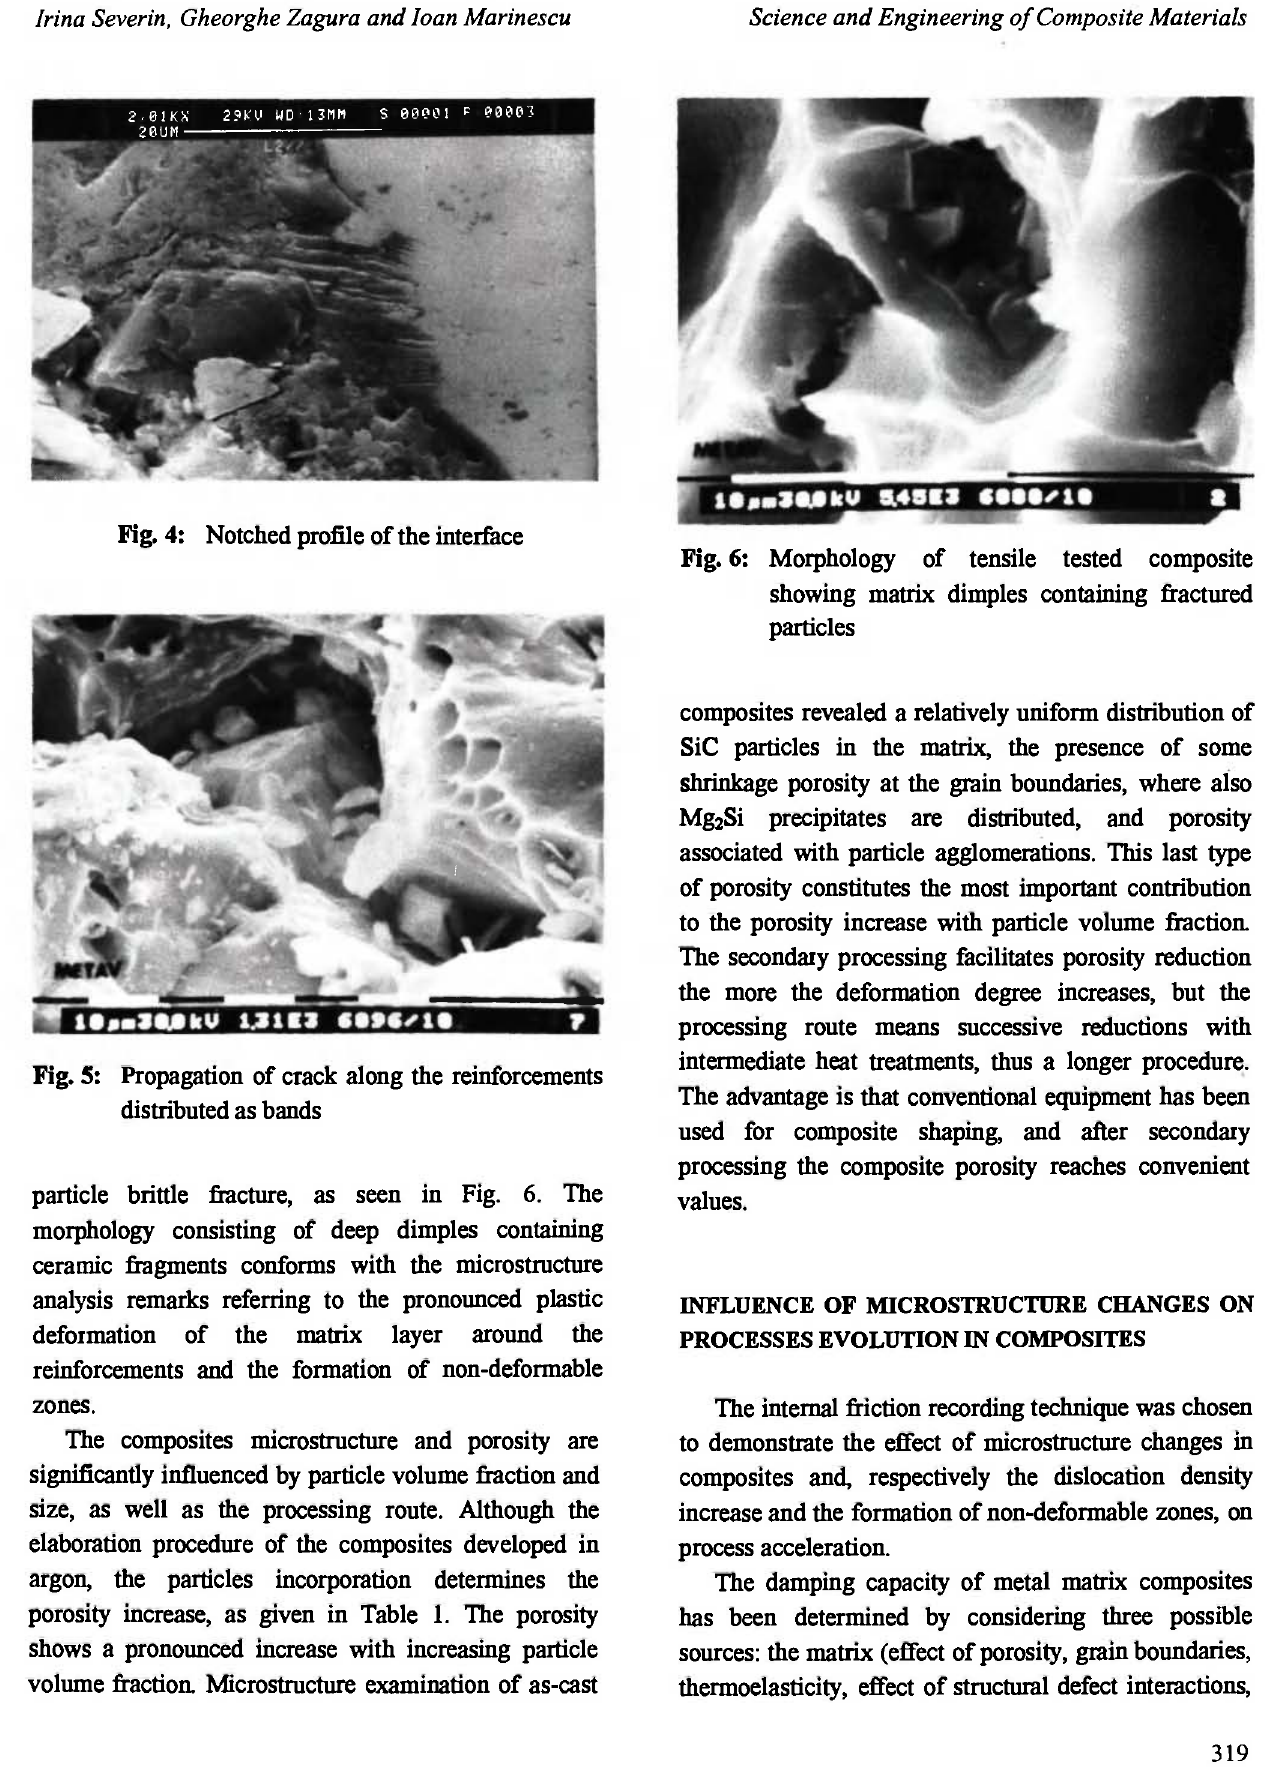
Fig. 4: Notched profile of the interface